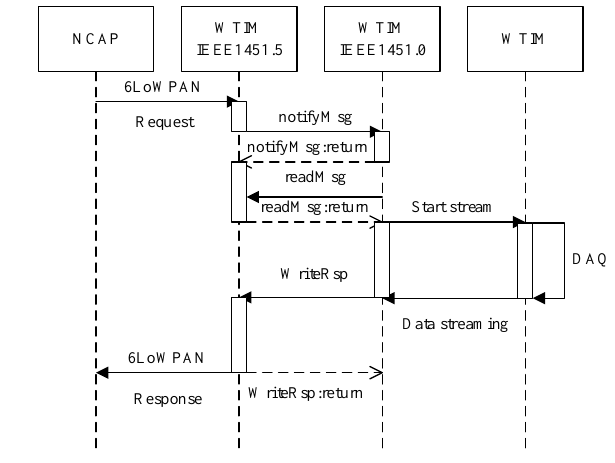
Figure 18. The sequence on the WTIM side. Table 3. Error and NRMSE of the estimated temperatures under S1.